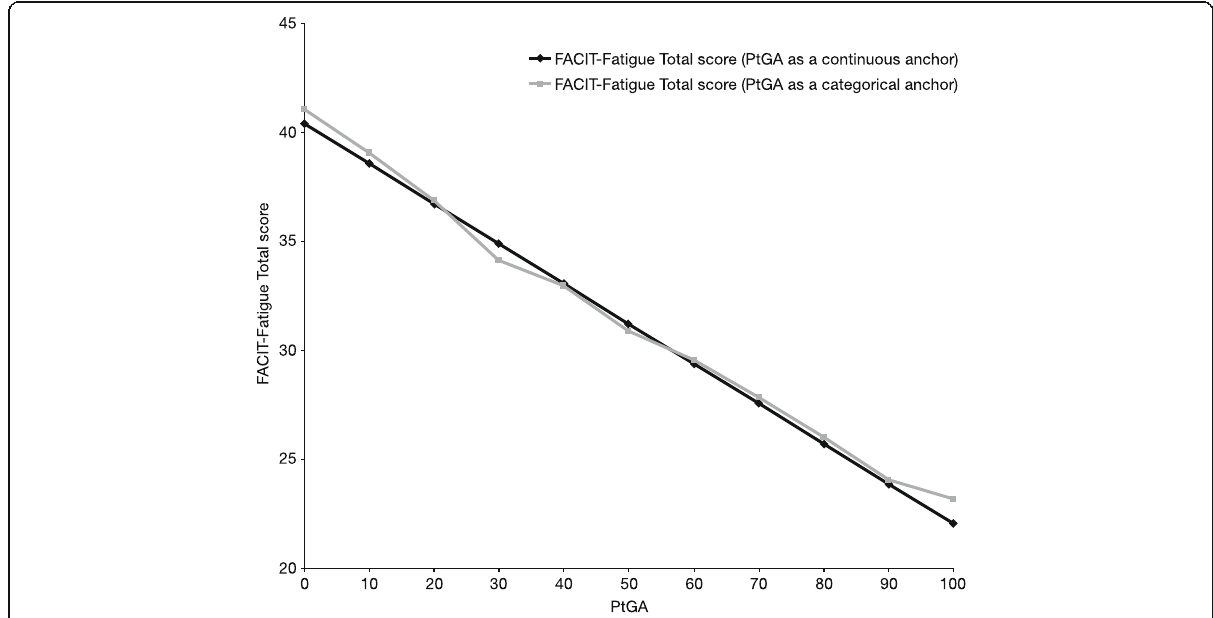
Fig. 1 Relationship between FACIT-Fatigue total score and PtGA as a continuous or categorical anchor. FACIT-Fatigue : Functional Assessment of Chronic Illness Therapy-Fatigue; PtGA : Patient ’ s Global Assessment of Psoriasis and